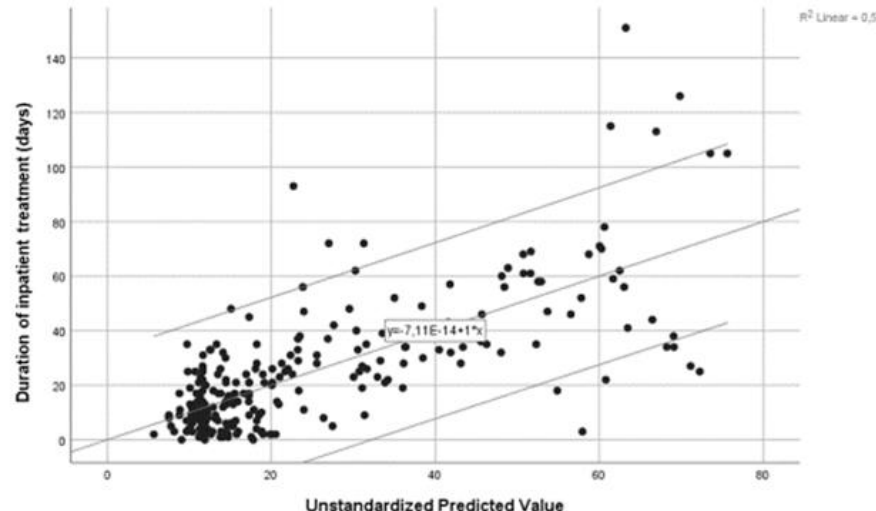
Figure 7. Scatter plot depicting the multivariate relationship between hospital stay duration and the independent variables bacteria number, ABSI score, TBSA, and inhalation injury, represented by the unstandardised predicted value. Line of best fit and confidence interval of 95%